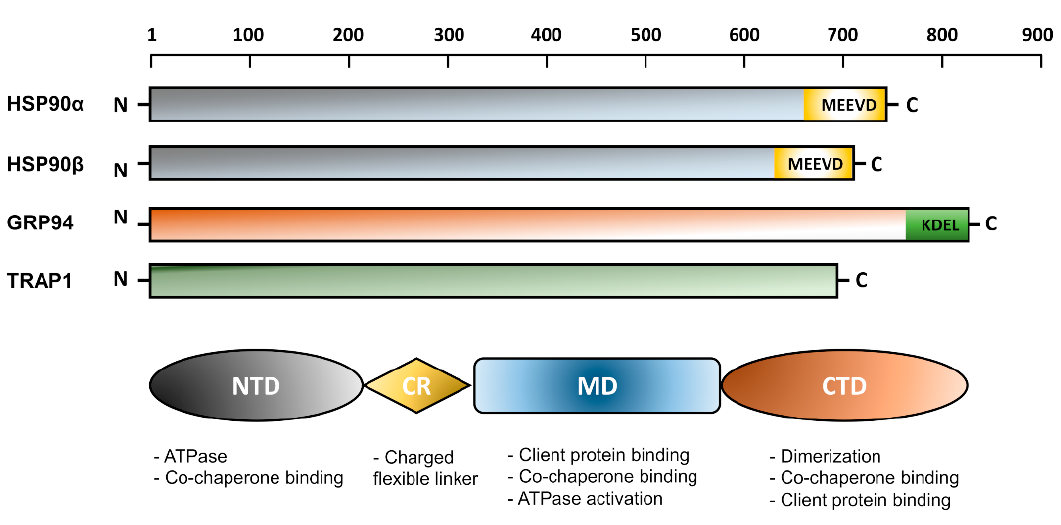
Figure 1. Domain structure of HSP90 family members in humans. The numbering 1–900 indicates the amino acid sequence. The lengths of HSP90 α , HSP90 β , GRP94, and TRAP1 are 732, 724, 704, and 803 amino acids, respectively. Below is shown a schematic representation of the domain structure of HSP90 isoforms together with the biological function of each domain.